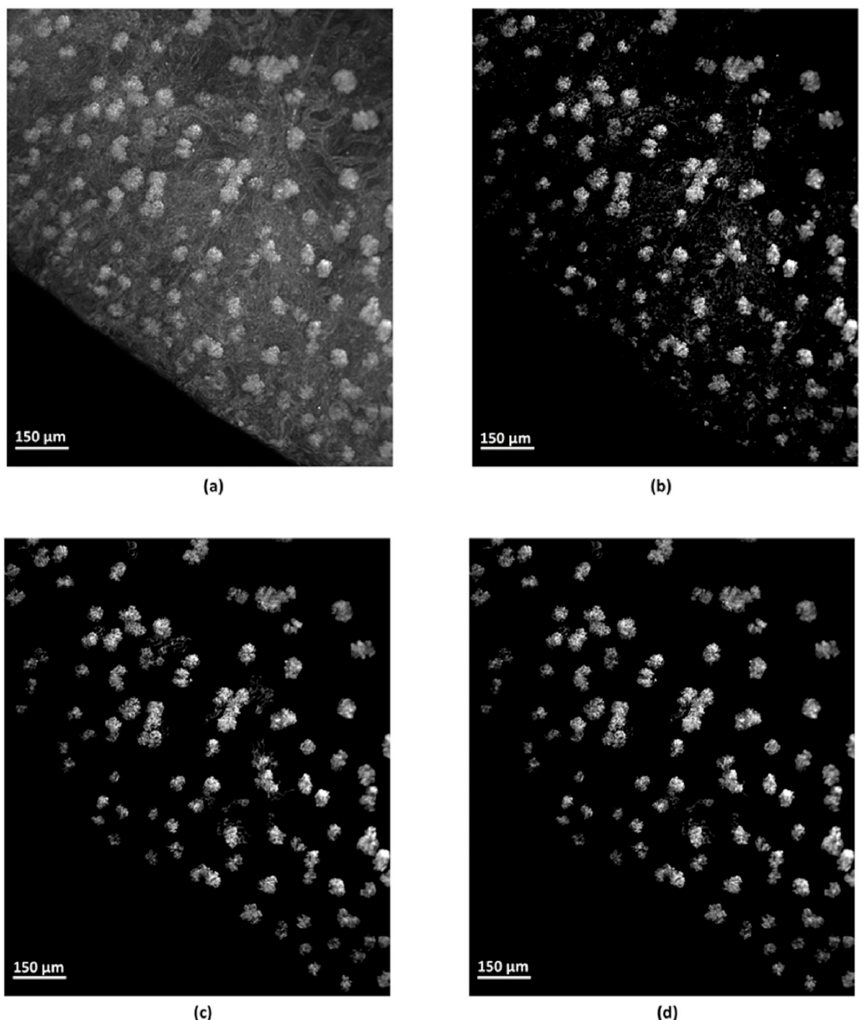
Figure 2. Segmented images of the renal tissue and glomeruli. ( a ) Representative renal cortex image after greyscale-based segmentation of the non-renal background. ( b ) Representative grey-level segmented image of the lectin-labelled structures after greyscale-based segmentation of the non- labelled renal tissue. ( c ) Representative volume segmented image of large lectin-labelled structures after the volume-based segmentation. ( d ) Representative shape segmented image of ellipsoid-shaped objects, i.e., renal glomeruli, after shaped-based segmentation. Lower left scale bar measures 150 µ